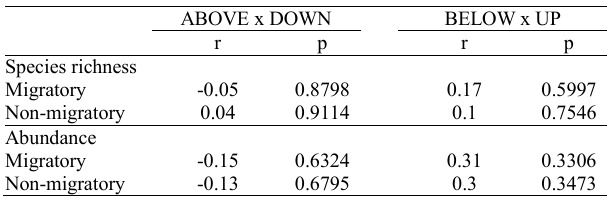
Table 1. Congruence (Spearman correlation) in the distribution of species richness and abundance (migratory and non- migratory fish) from month to month in terms of the contrasts ABOVE x DOWN and UP x BELOW.